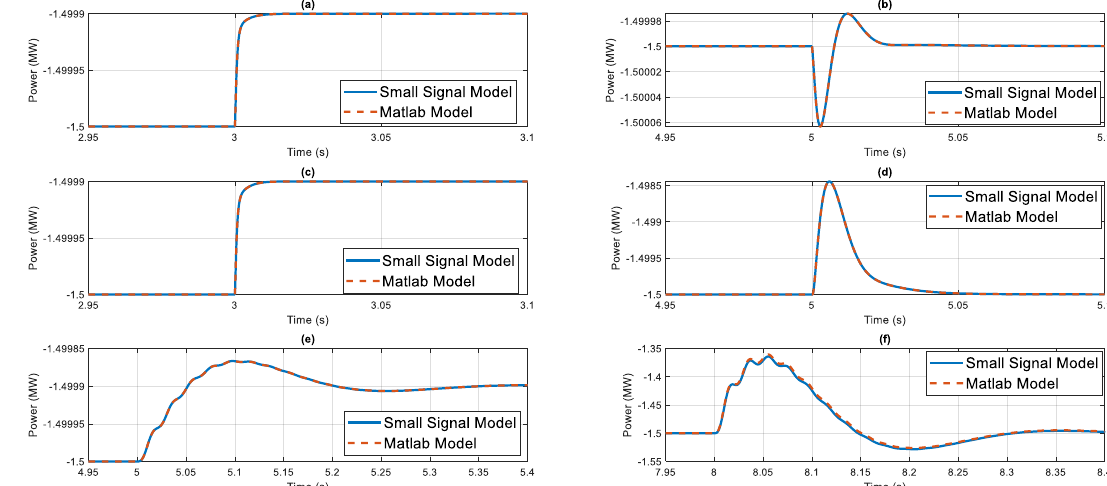
Figure 8. Validation of the battery-connected small-signal models: ( a ) net power command step (100 W) to net power for PVCC, ( b ) net frequency step (0.2 rad/s) to net power for PVCC, ( c ) net power command step (100 W) to net power for PVCC with inertia emulation (PVCCI), ( d ) net frequency step (0.2 rad/s) to net power for PVCCI, ( e ) net power command step (100 W) to net power for VSM and ( f ) net frequency step (0.2 rad/s) to net power for VSM.